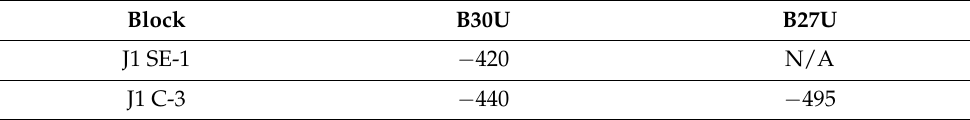
Table 4. Depths of gas–oil contact (m) for the B27